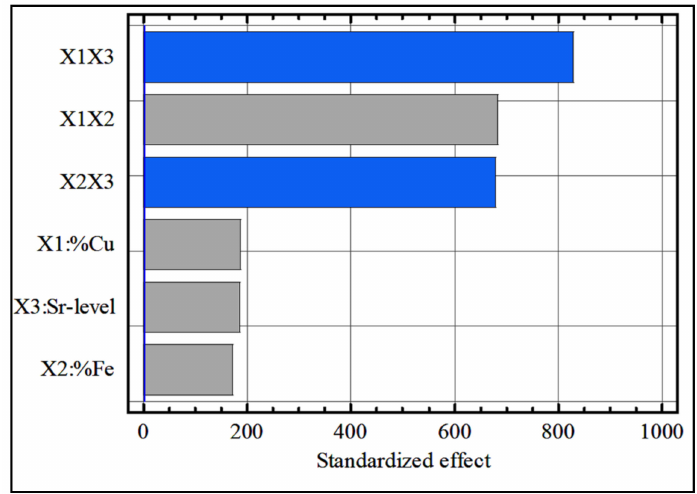
Figure 9. Pareto chart of the standardized effects for tool life